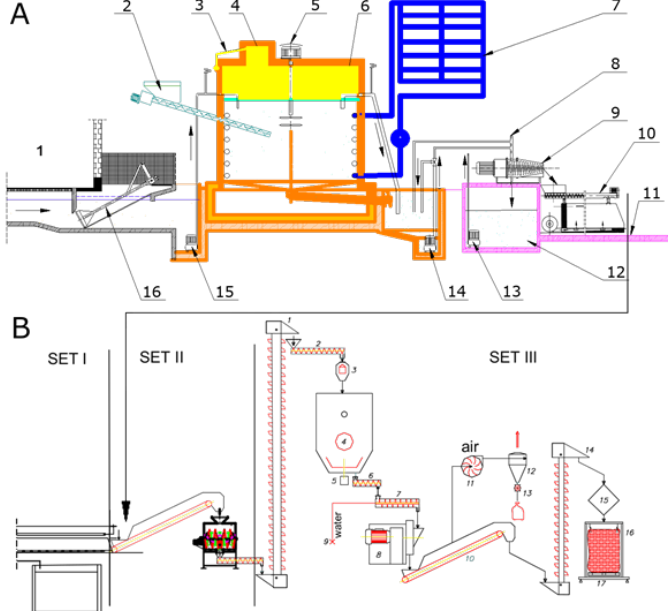
Figure 7. A scheme of the line for the production of granular fertilizer from fermented ( A ) or unfermented ( B ) substrates (own study). A—Schematic diagram of an agricultural biogas plant with a separator for the fermented substrate to a solid fraction with a storage system and liquid fractions: 1—livestock building, 2—fermentation chamber, 3—biogas pipeline to the biogas purification plant, 4—agitator, 5—overflow pipe, 6—feeder for plant substrates, 7—solar collector with pump and heat exchanger, set A: 8—separator, 9—a pipeline for feeding liquid digestate with overflow pipe from the separator, 10—screw relay, 11—plate for separated solid fraction, 12—intermediate tank for separated liquid post-fermentation fraction, 13—slurry agitator in slurry channels; 14—pump with fresh slurry feeding pipeline, 15—pump with slurry mixing and feeding pipeline to the separator, and 16—pump for pumping separated slurry. B—Solid fractional mixer-dryer and process line for granulating the dried substrate. A detailed description of the individual markings is shown in Figures